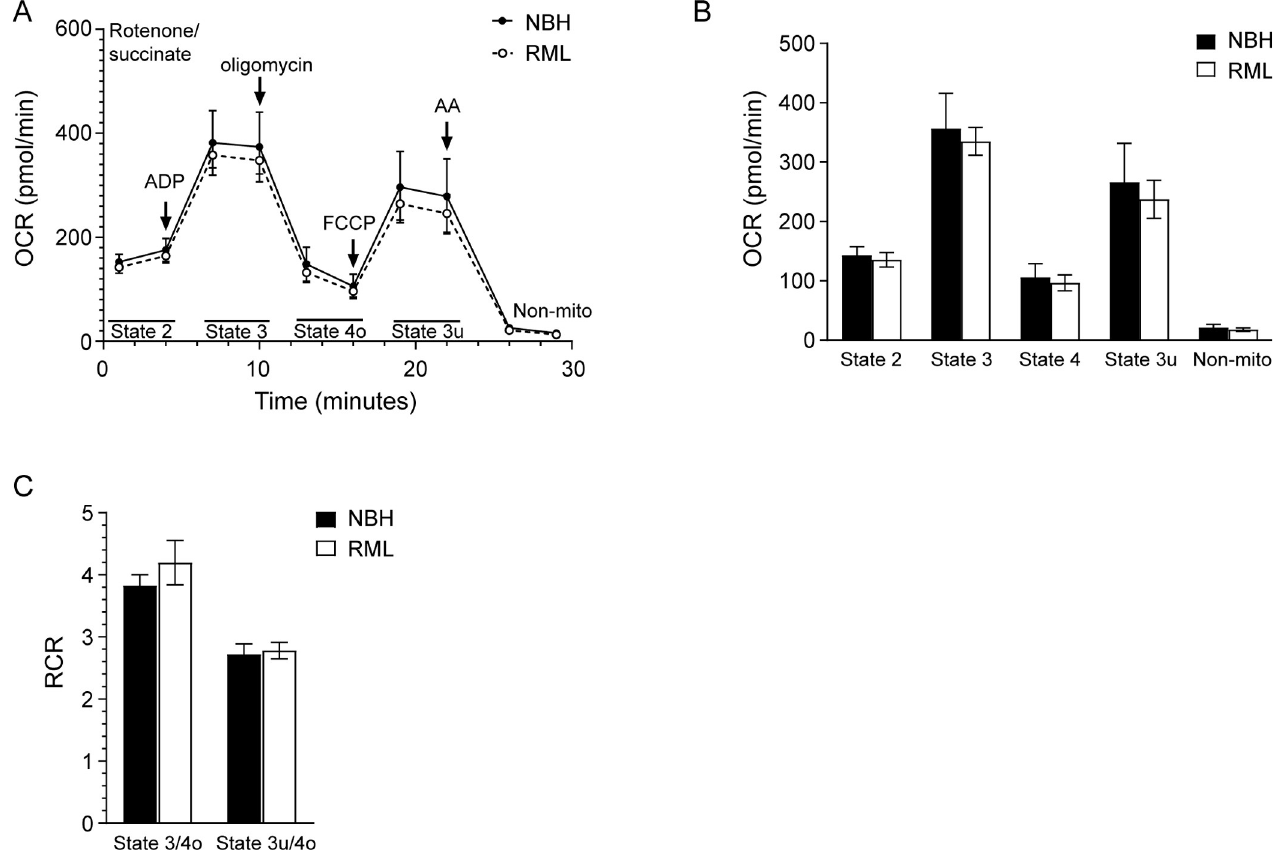
Fig 6. No difference in mitochondrial oxygen consumption in C57Bl/6 mice infected with RML prions. (A) Mitochondrial coupling assay measuring mitochondrial respiration for clinically positive C57Bl/6 mice infected with RML prions (open circle, dotted line) or inoculated with NBH (black circle, solid line). A total of n = 5 mice were assayed for each condition. The reagents added during the 30 min assay as well as the states quantified are indicated. AA = antimycin A; Non-mito = non mitochondrial respiration. (B) OCRs and (C) RCRs for the data in Panel A. Values were calculated as described in the materials and methods. Black bars = NBH inoculated, white bars = RML inoculated. For all panels, the mean ± SEM is shown.